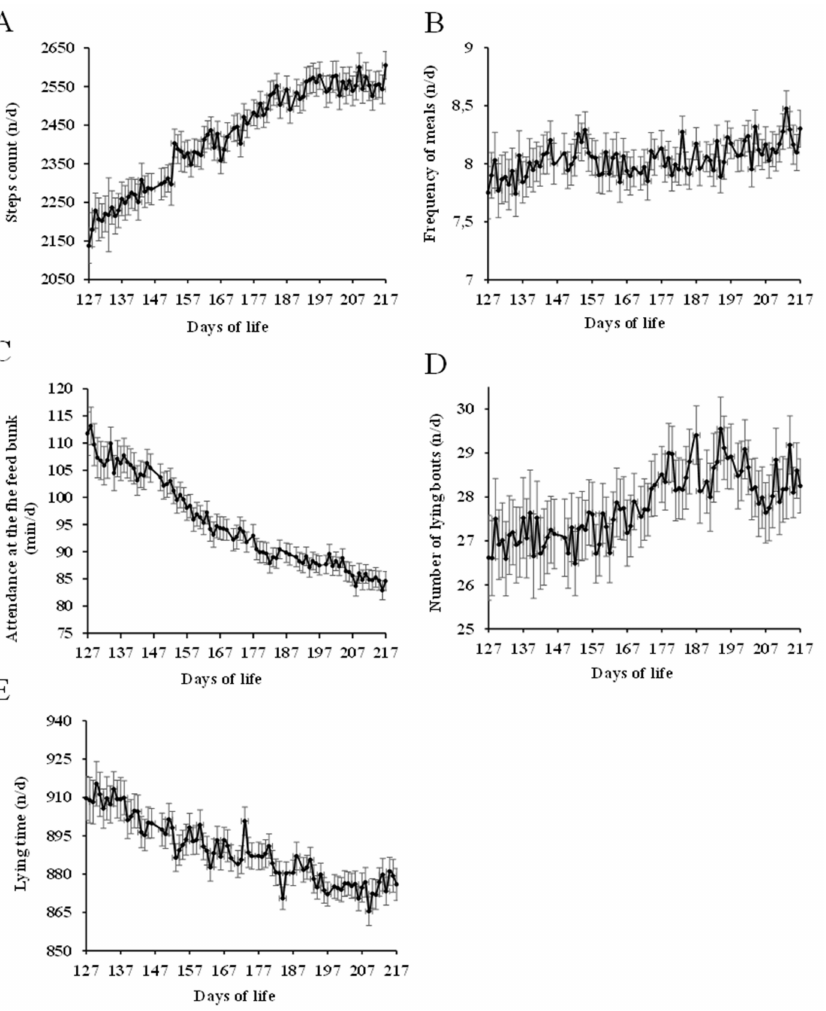
Figure 1. Daily steps counts n / day ( A ), frequency of meals n / day ( B ), attendance at the feed bunk min / day ( C ), number of lying bouts n / day ( D ) and lying time min / day ( E ) in healthy bulls from 127 to 217 days of